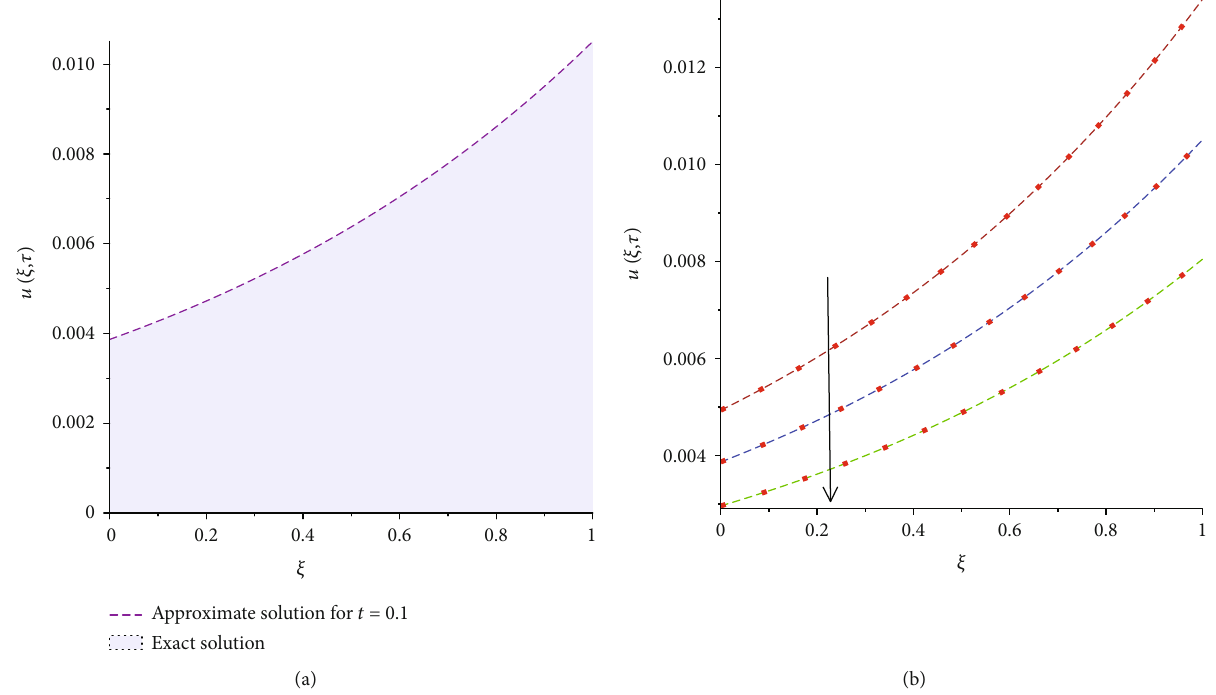
Figure 2: Graphical representation of exact and approximate solution for di ff erent values of ξ in entire domain (a) and various values of τ = 0 : 1,0 : 2,0 : 3 in downward direction (b) of Example i.e., τ f